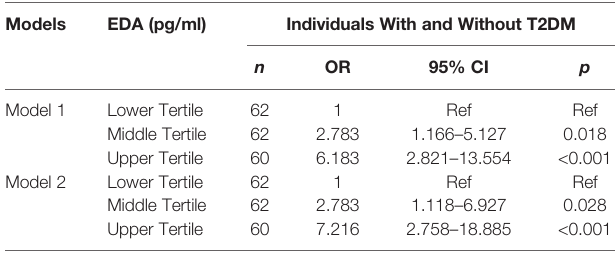
TABLE 6 | OR and 95% CI for T2DM by the tertiles of Ectodysplasin A.